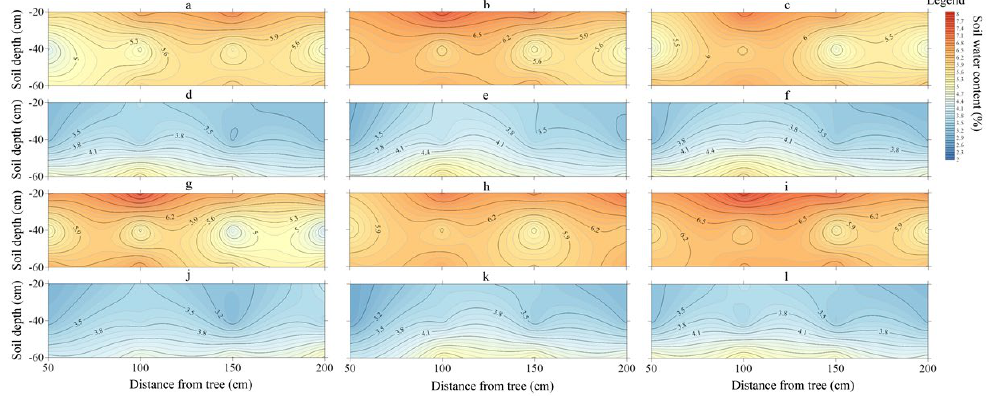
Figure 3. Two−dimensional soil Na + content distribution in different stages of monocropping apple and ryegrass apple intercropping system (( a , d , g , j ): flowering and fruiting period; ( b , e , h , k ): fruit enlarging period; ( c , f , i , l ): fruit maturing period; monocropping apple (first and third rows) and ryegrass apple intercropping system (second and fourth rows); in the 2020 (top two rows) and 2021 (bottom two rows)